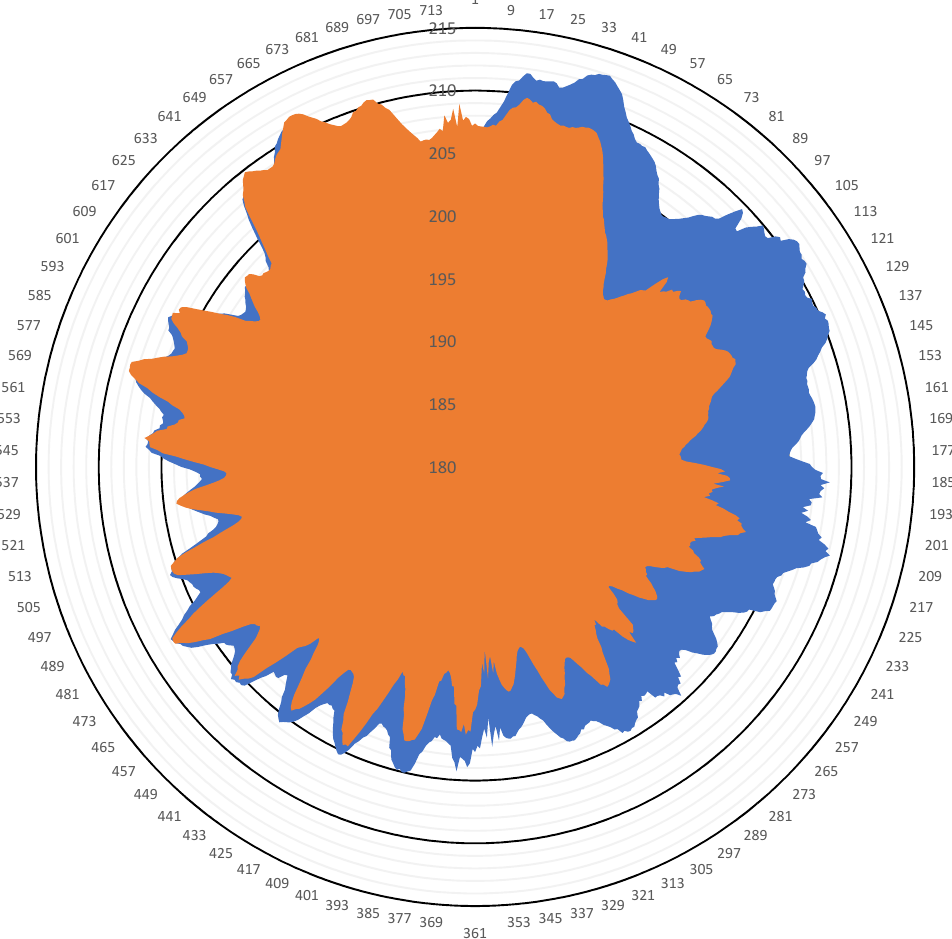
Figure 24. Changes in the instantaneous rotational speed of the engine shown in the form of a polar coordinate system. Blue: engine in up-state; Orange: cylinder 1 misfire.